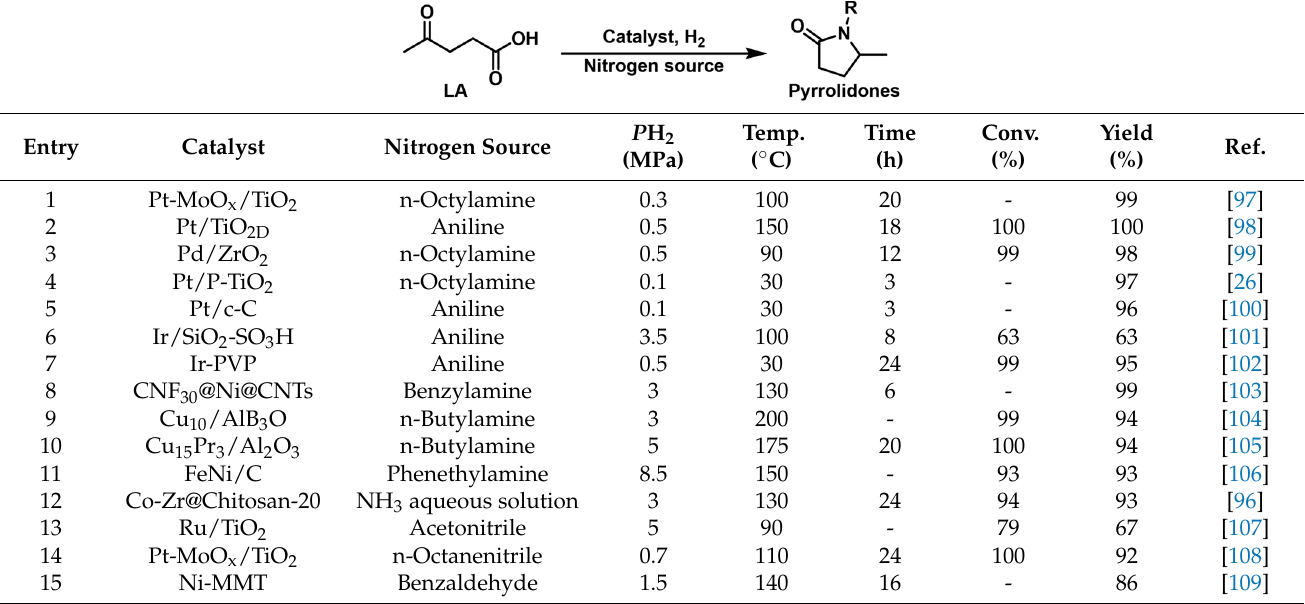
Table 6. Reductive amination of LA with different nitrogen sources.